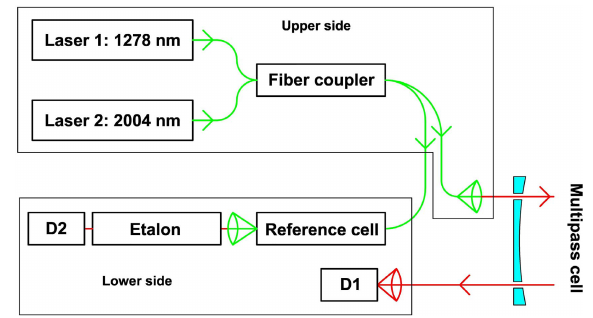
Figure 1. Optical scheme of the analyser. The outer line encompass the components according to their locations, as in Fig. 2.